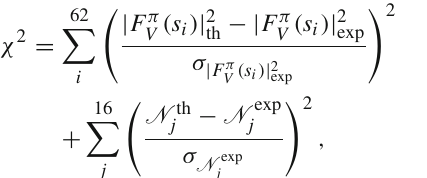
Table 8 Simultaneous fit results for different choices regarding res- onance mixing and linear slopes parameters obtained with a three- times-subtracted dispersion relation including three vector resonances ( s ) and F K ( s ) accordingtoEqs.(26)and(53)with s in F π V V in the dispersive integral Parameter s cut = 4 (GeV 2